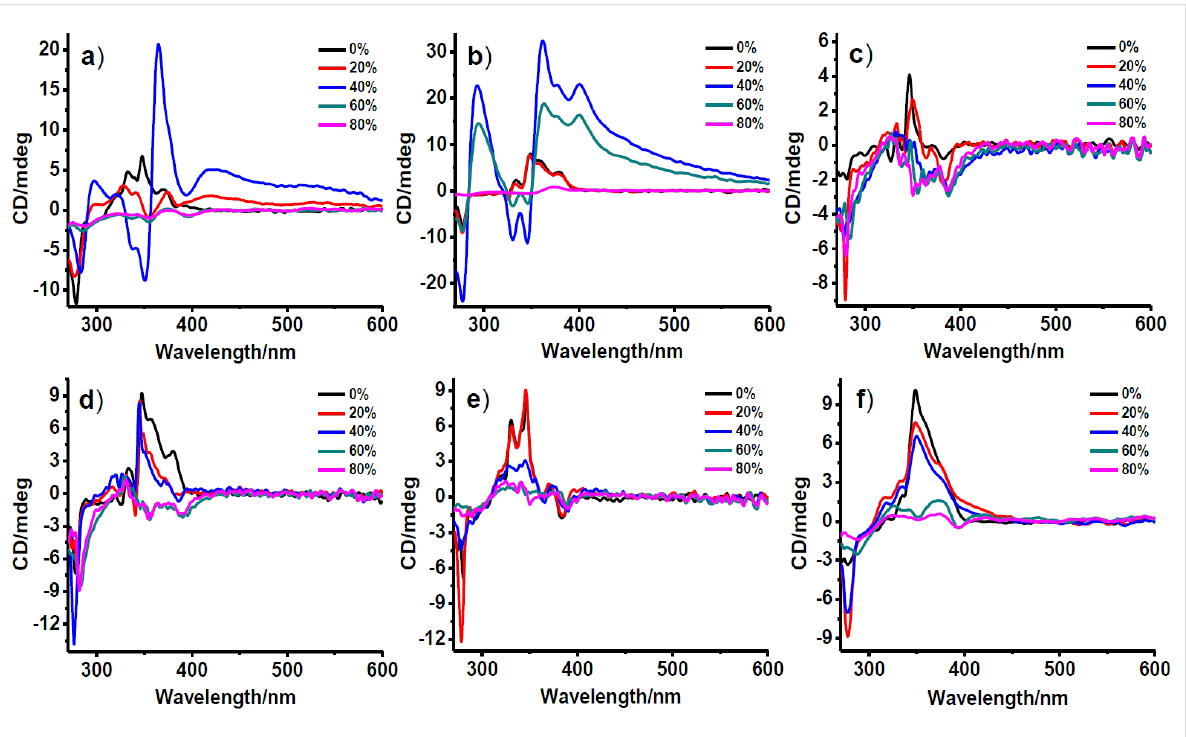
Figure 3: CD spectra of (a) and (b) 1 , (c) and (d) 2 , and (e) and (f) 3 for various percentages of water in aqueous DMSO (a, c and e) and aqueous NMP (b, d and f). Concentration of 1 , 2 and 3 used was 400 μ M.